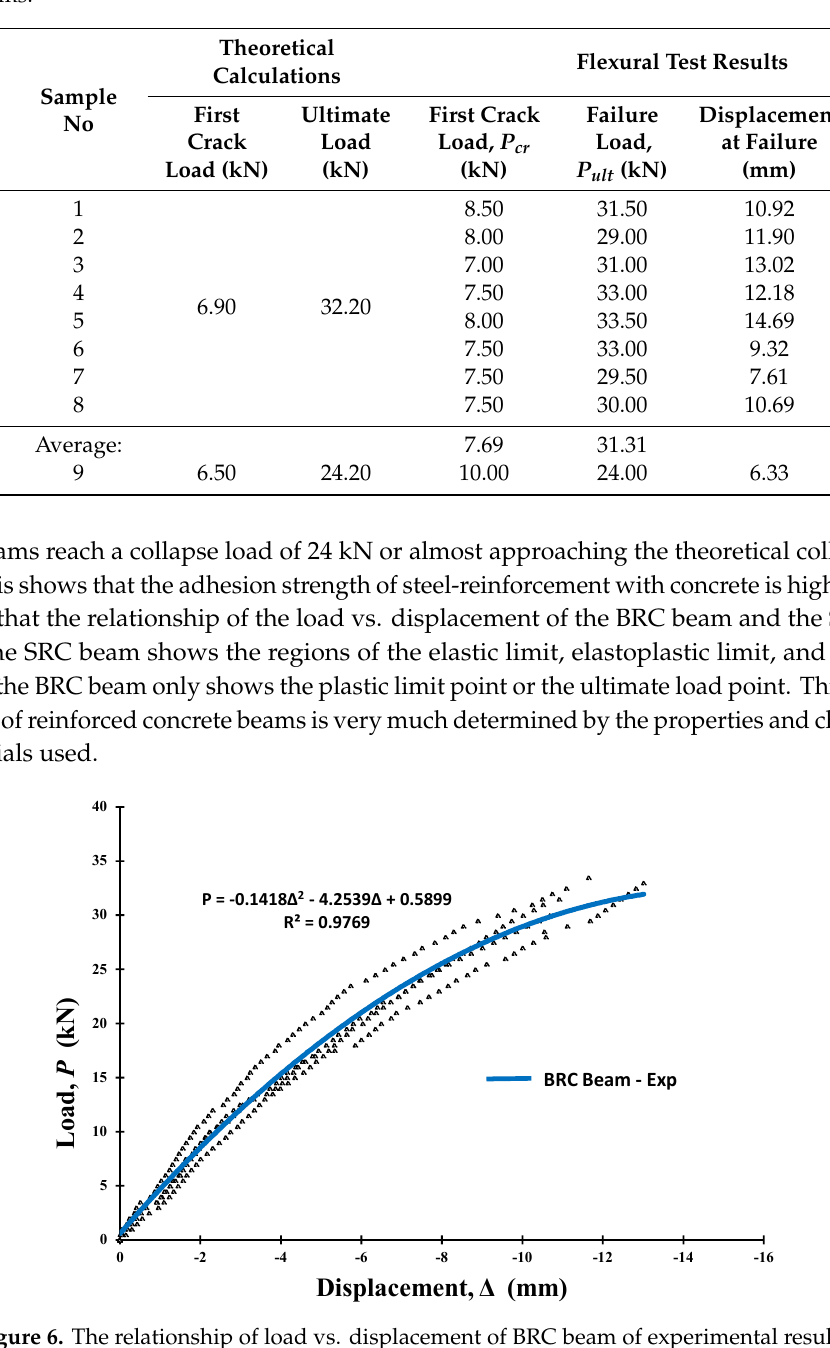
Table 5. Results of theoretical calculations and experimental for the load capacity of BRC beams and SRC beams.